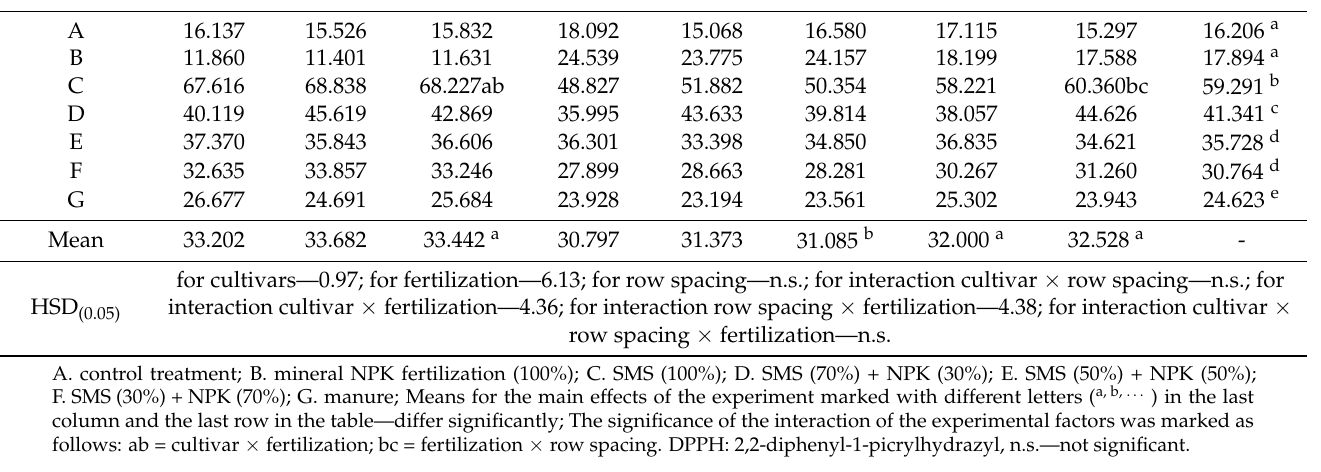
Table 7. DPPH radical scavenging activity determined in thyme raw material ( µ M TE g − 1 ). Fertilization